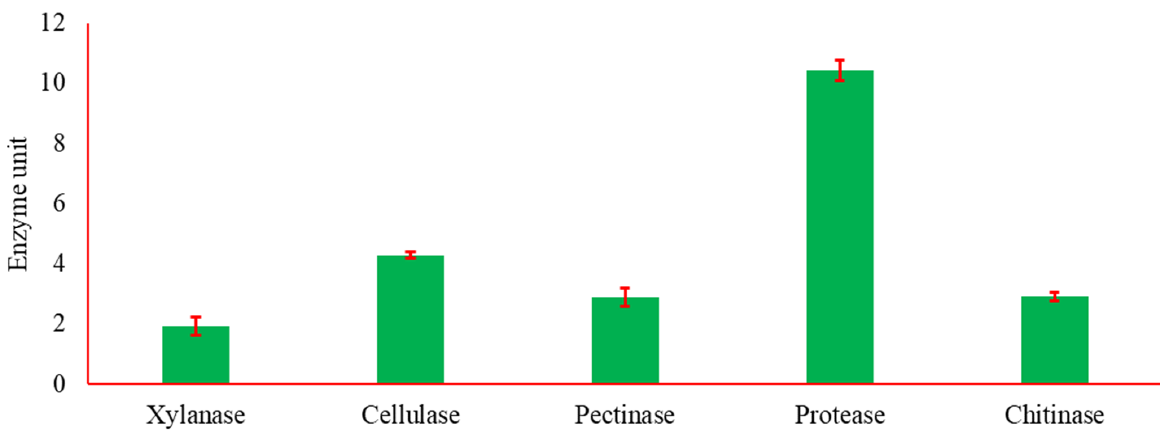
Figure 5. The hydrolytic enzymes’ activity of the bioagent T. asperellum ZNW (n = 3).